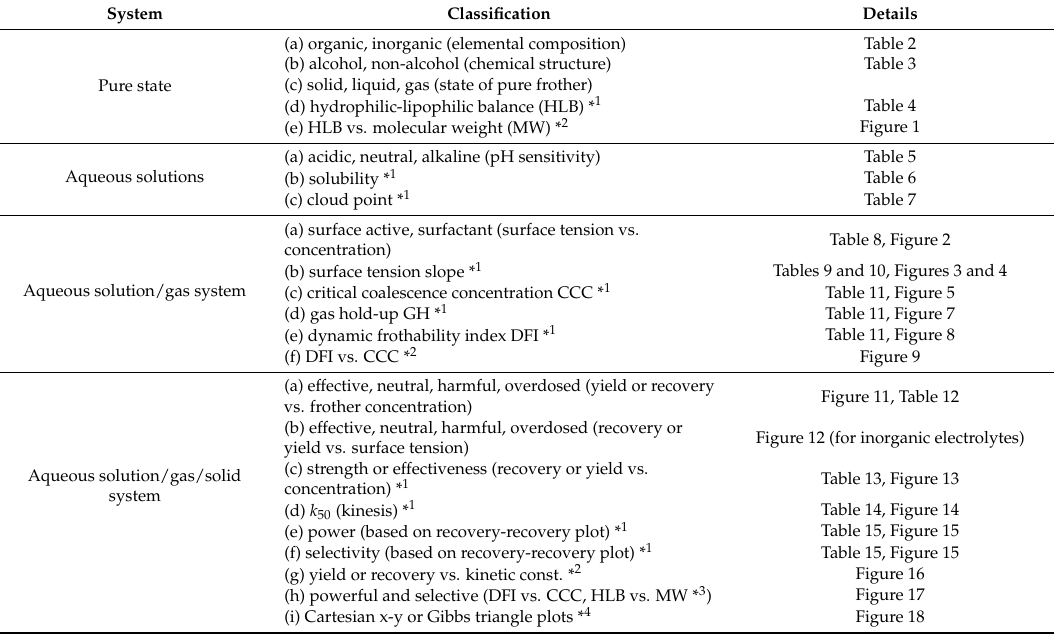
Table 1. Frothers classification system based on four physical systems and number of numerical values used for classification.